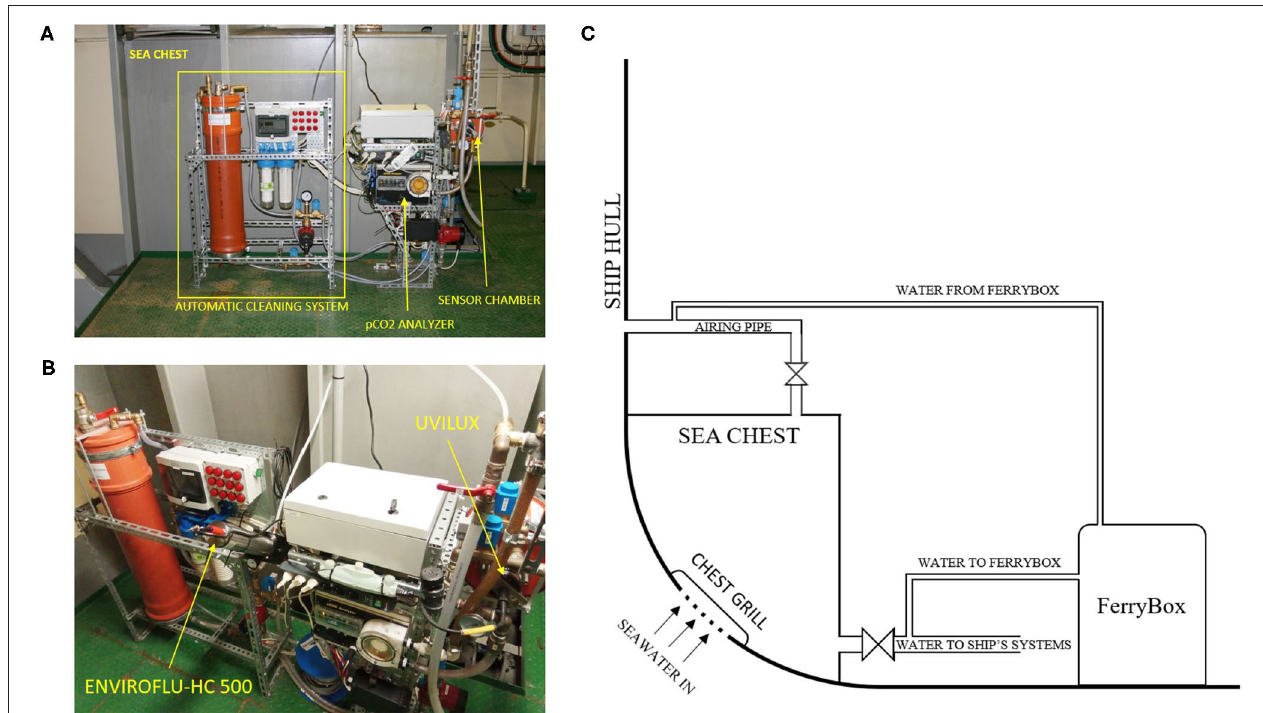
FIGURE 2 | FerryBox system on board M/S Baltic Queen (A) and the same system with UviLux and EnviroFlu-HC fluorometers during the experiment (B) . General scheme of the FerryBox’s placement and water flow on M/S Baltic Queen is shown on figure (C) . Photographs: Kaimo Vahter.